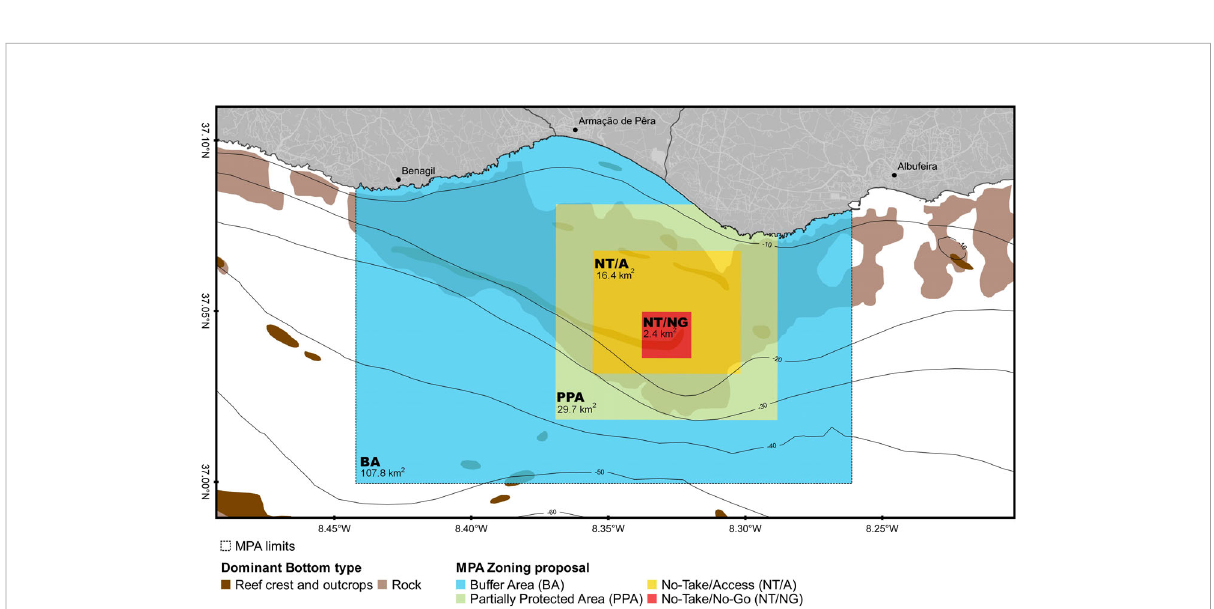
FIGURE 6 First proposal of MPA zoning and respective general regulations as presented in the First zoning workshop (3rd session of the multi-stakeholder workshops).